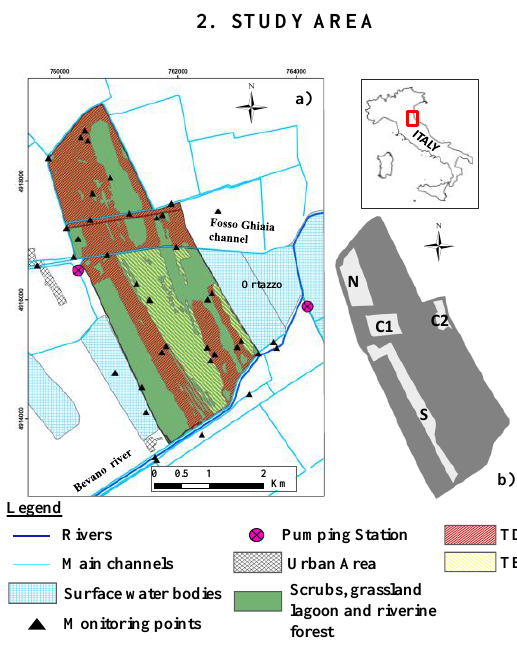
Figure 1. Classe pinewood (a) and the Areas of Interest (b) The historical Classe pinewood (Fig. 1 (a)), included in the Po Delta Regional Park (Ravenna, Italy) because of its considerable plant and animal biodiversity, is 5 km long and 2 km large (900 ha). The pine forest is mainly surrounded by agricultural land except for the South-East part where it borders with the Ortazzo freshwater lagoon. The thickness of the underlying aquifer varies from a minimum of 6 to a maximum of 22 m (Amorosi et al.